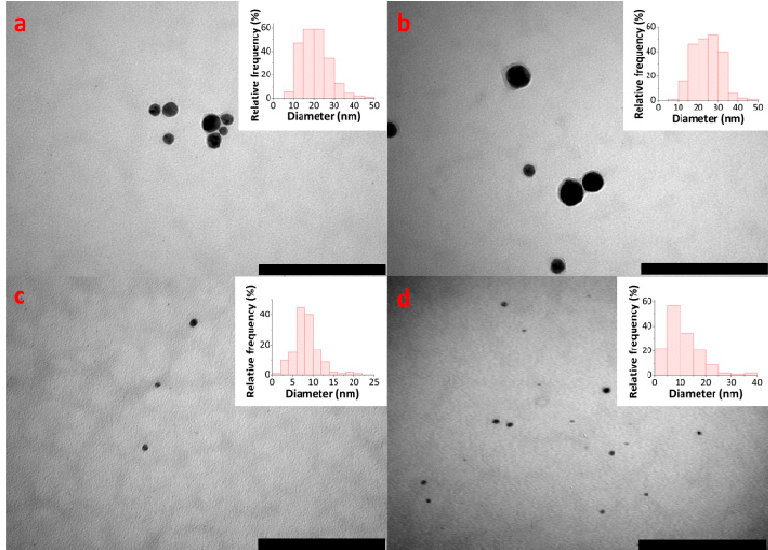
Figure 6. TEM micrographs and size distribution of the AgNPs for the nanocomposites with a ratio ( 4 ) for Polymer A ( a ) (226 NPs), Polymer B ( b ) (216 NPs), Polymer C ( c ) (143 NPs), and Polymer D ( d ) (148 NPs). The scale bar is 200 nm.